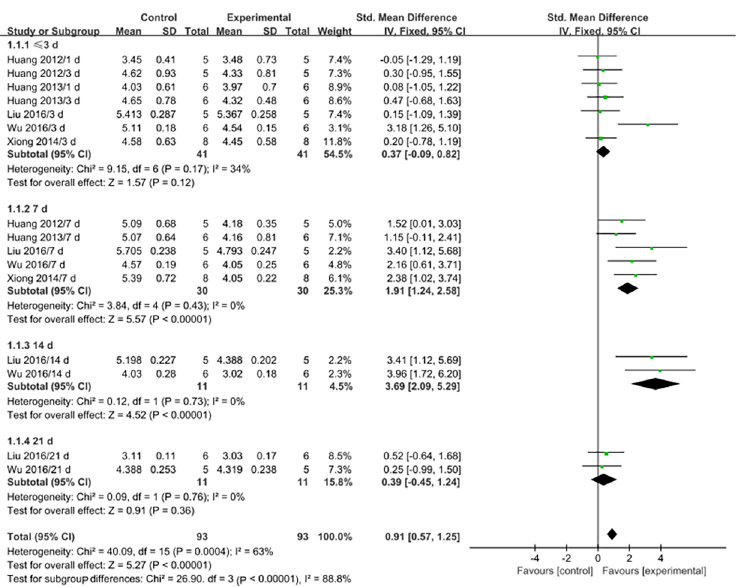
Fig 2. Forest plots showing the effects of MSCs on MDA levels. Control: PQ group; Experimental: MSC treatment group; CI: confidence interval; IV: independent variable; SD: standard deviation.